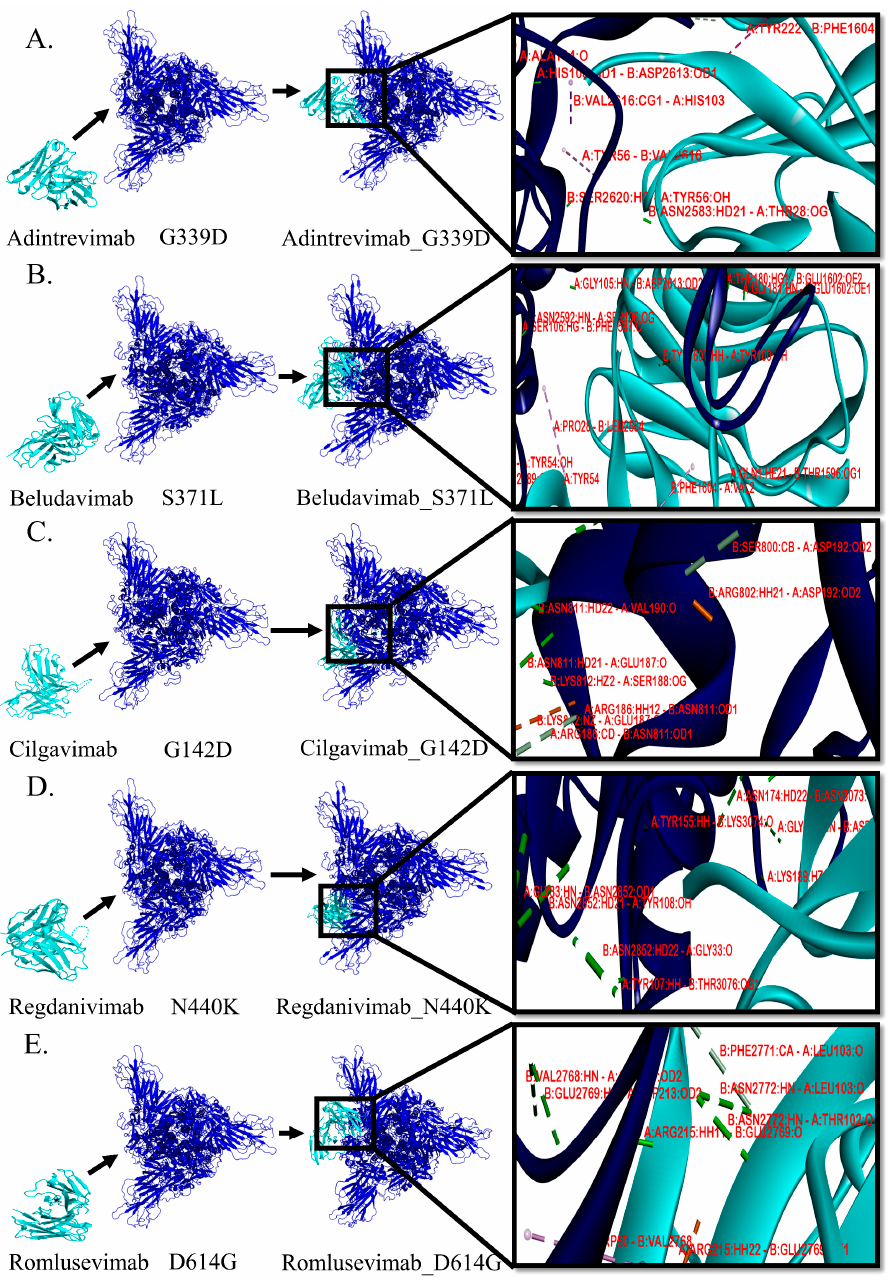
Figure 1. Comparative analyses on the binding pattern and binding topology of 5 mAbs–omicron spike protein complexes. ( A ) Interaction between adintrevimab and G339D, ( B ) beludavimab and S371L, ( C ) cilgavimab and G142D, ( D ) regdanivimab and N440K and ( E ) romlusevimab and D614G. (Blue colour is depicting the omicron variant and cyan for mAbs).